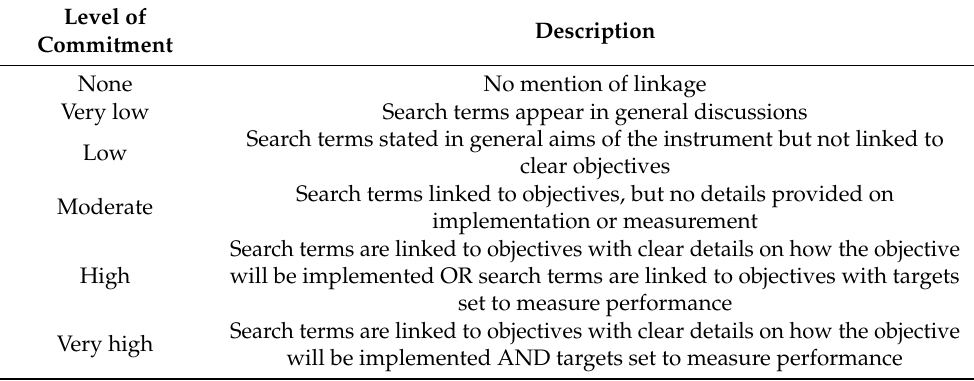
Table 3. Classification of the level of political commitment.